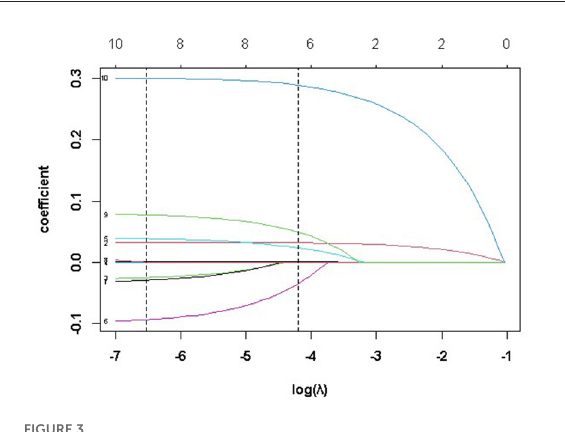
FIGURE3 Penalty parameter ( λ ) and coefficient